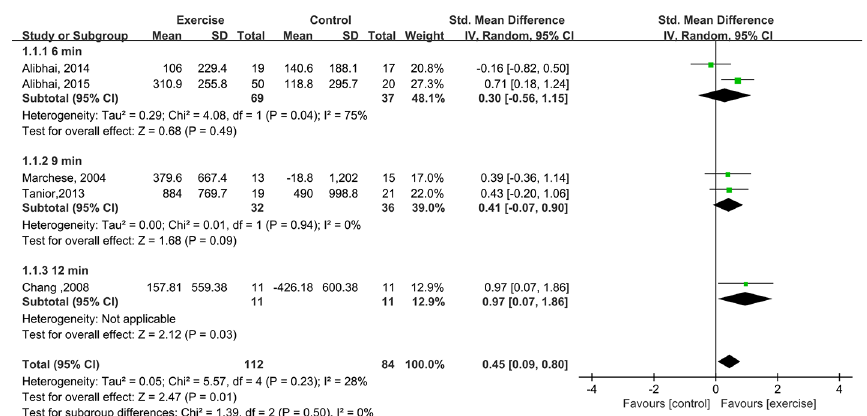
Fig 4. Forest plot comparing the changes in cardiorespiratory fitness between the exercise and control groups.